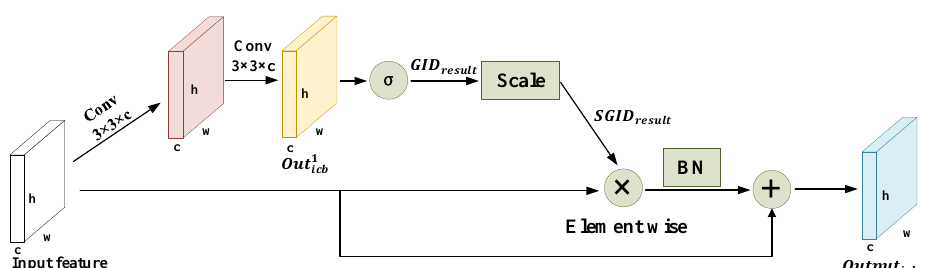
Figure 7. The framework of the information correction block (ICB